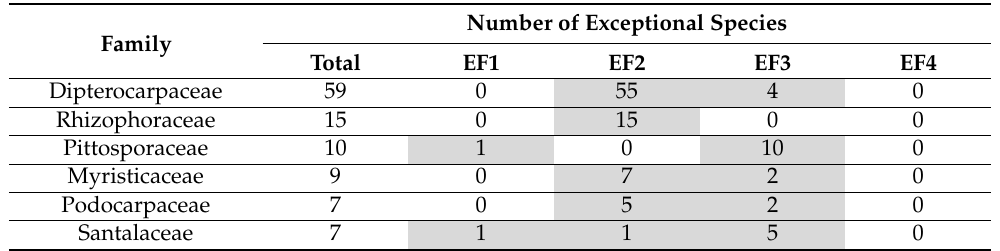
Table 6. Families with two or more species listed in the current Working List of Exceptional Plants, but with no articles identified in the Web of Science literature